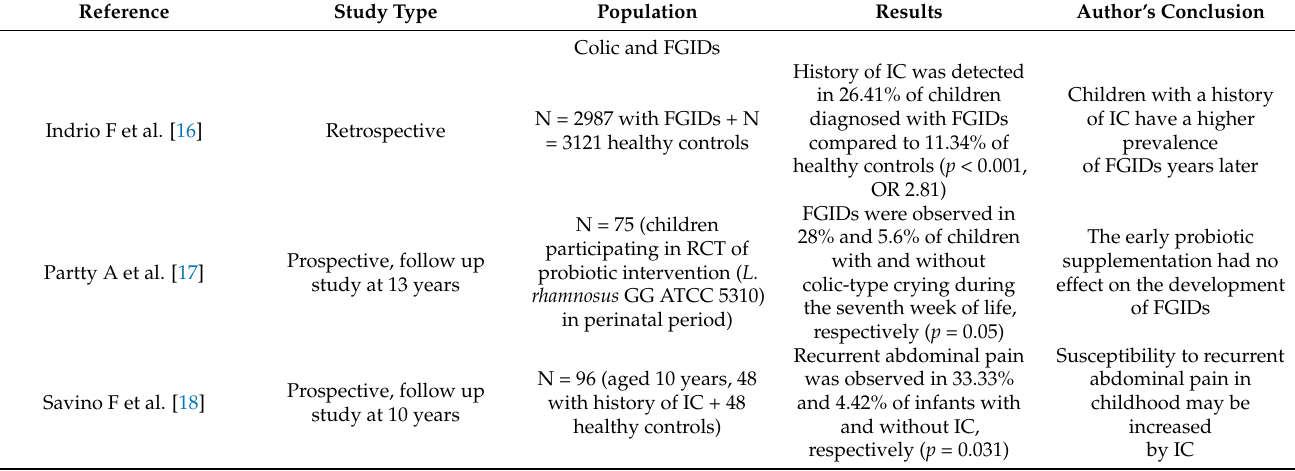
Table 1. Summary of studies on long-term consequences of excessive crying and/or